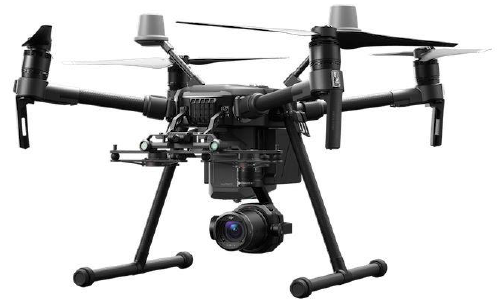
Figure 21. DJI Matrice 210 and Zenmuse 4XS.